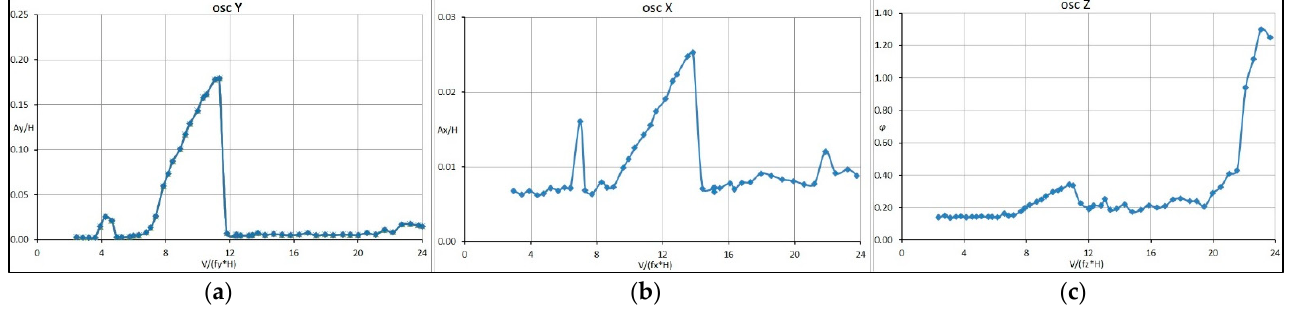
Figure 10. ( a ) The intensity of aeroelastic vibrations of the model in the horizontal plane; ( b ) The intensity of aeroelastic vibrations of the model in the vertical plane; ( c ) Intensity of torsional aeroelastic vibrations of the model.